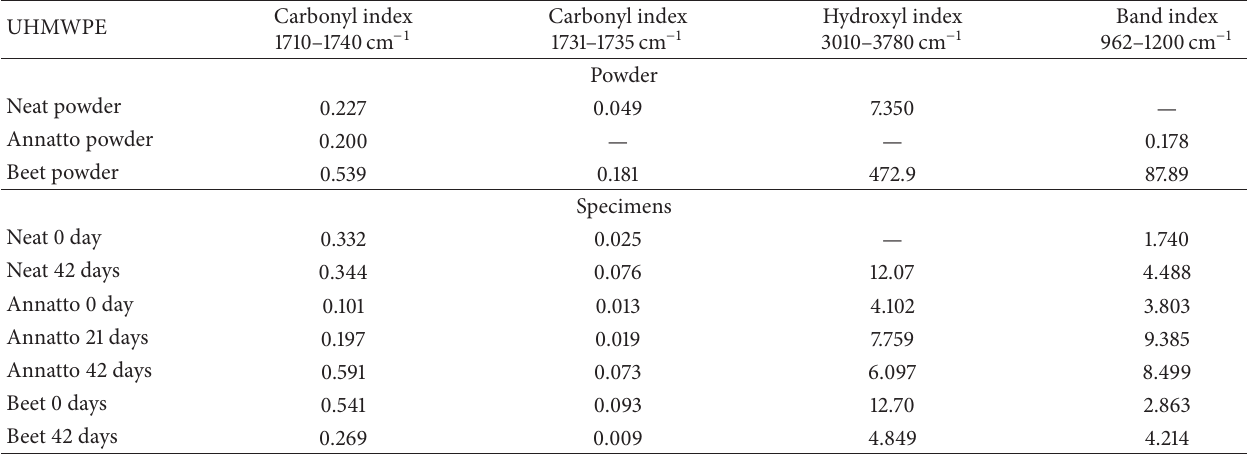
Table 1: Carbonyl, hydroxyl, and the one referent to band between 962 and 1200 cm −1 indexes with the time exposure.